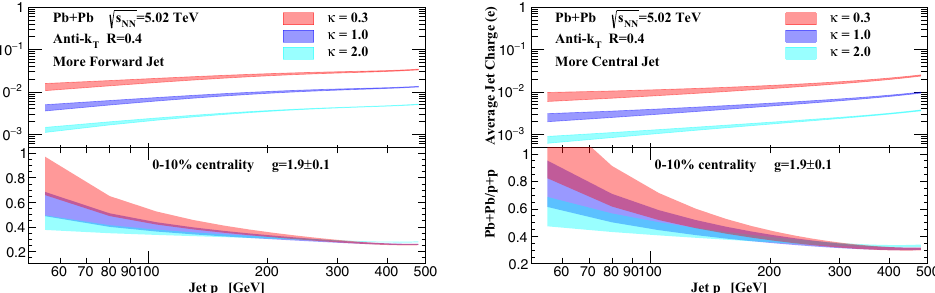
Figure 2. Transverse momentum dependence of the average jet charge distributions for more forward jets in dijet events at √ s NN = 8 TeV in p + p collisions. The non-perturbative parameters are obtained by fitting to PYTHIA Figure 4. Average jet charge distribution for more forward (right) and more central (left) jet with κ = 0.3, 1.0 simulations (left) and ATLAS measurements (right). and 2.0 in Pb + Pb collisions with √ s NN = 5.02 TeV with nonperturbative parameters from PYTHIA. The bottom panels show the modification of the average jet charge in 0-10% central Pb + Pb collisions relative to the ones in p + p